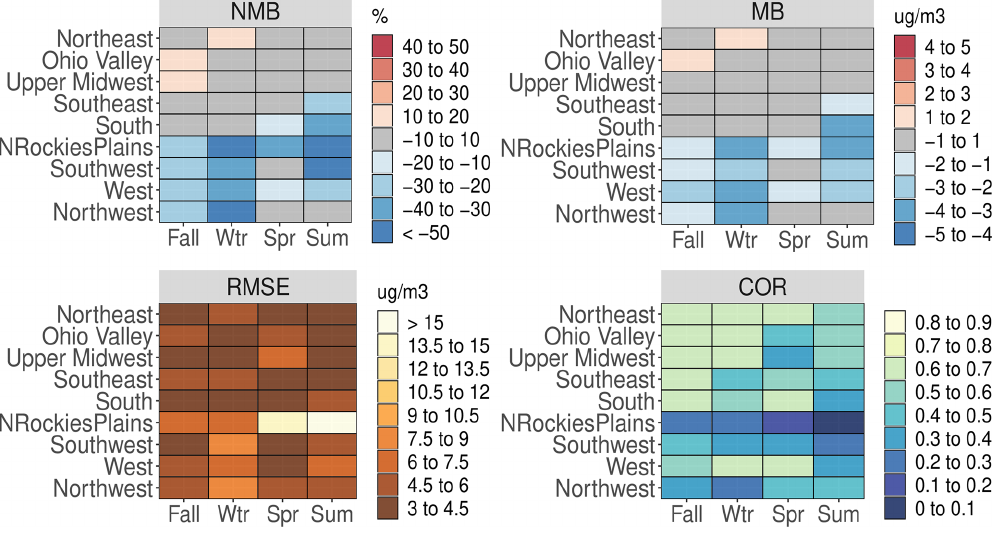
Figure 4. NMB (%), MB (µgm − 3 ), RMSE (µgm − 3 ), and Pearson correlation coefficient (COR) values for daily average PM 2 . 5 for all AQS sites based on season and NOAA climate region for the CMAQ531_WRF411_M3Dry_BiDi